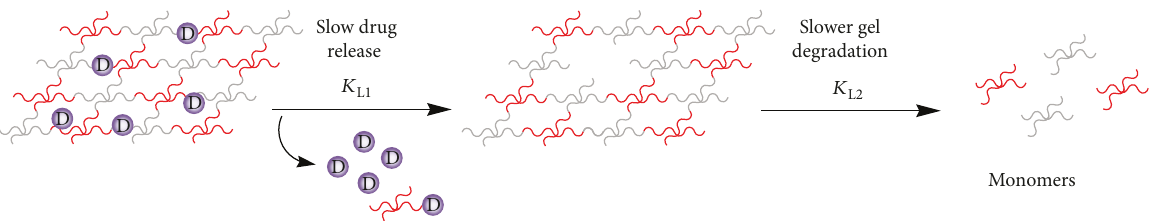
Figure 1: Depiction of chemically controlled drug release and subsequent degradation of a Tetra-PEG hydrogel with β -eliminative crosslinks.